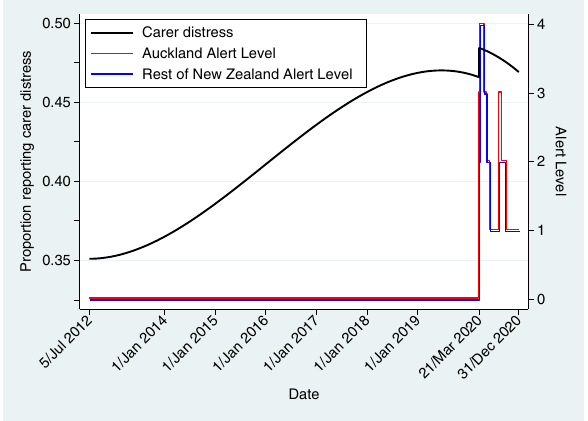
Figure 1. The best fitting fractional polynomial model of recorded carer distress over time for first interRAI-HC assessments, together with the COVID-19 Alert Level changes for Auckland and the rest of New